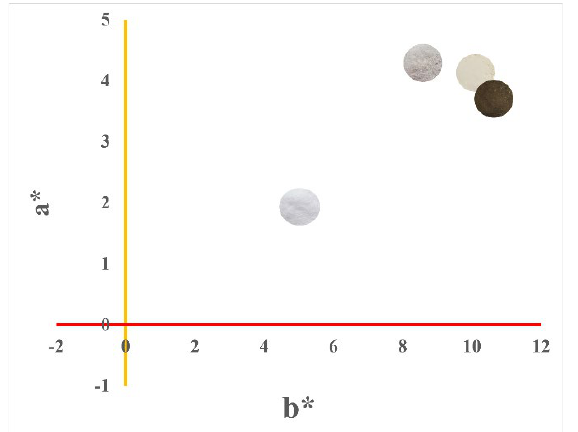
Figure 7. Graph of colorimetric parameters +a* (yellow) vs. +b* (red). Colorimetric measurements (L*a*b*) were performed on the respective samples in the form of powder.